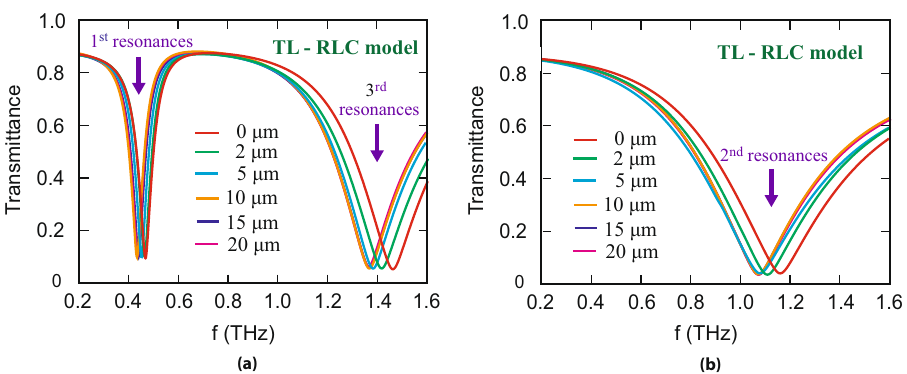
Figure 7. Terahertz transmittance through the typical metamaterial geometry obtained from TL-RLC circuit model for different thicknesses of analyte. The results are in good agreement with the numerical findings. ( a ) Terahertz transmittance for polarization parallel to the split gap of SRR. ( b ) Represents the transmittance for polarization perpendicular to the gap of